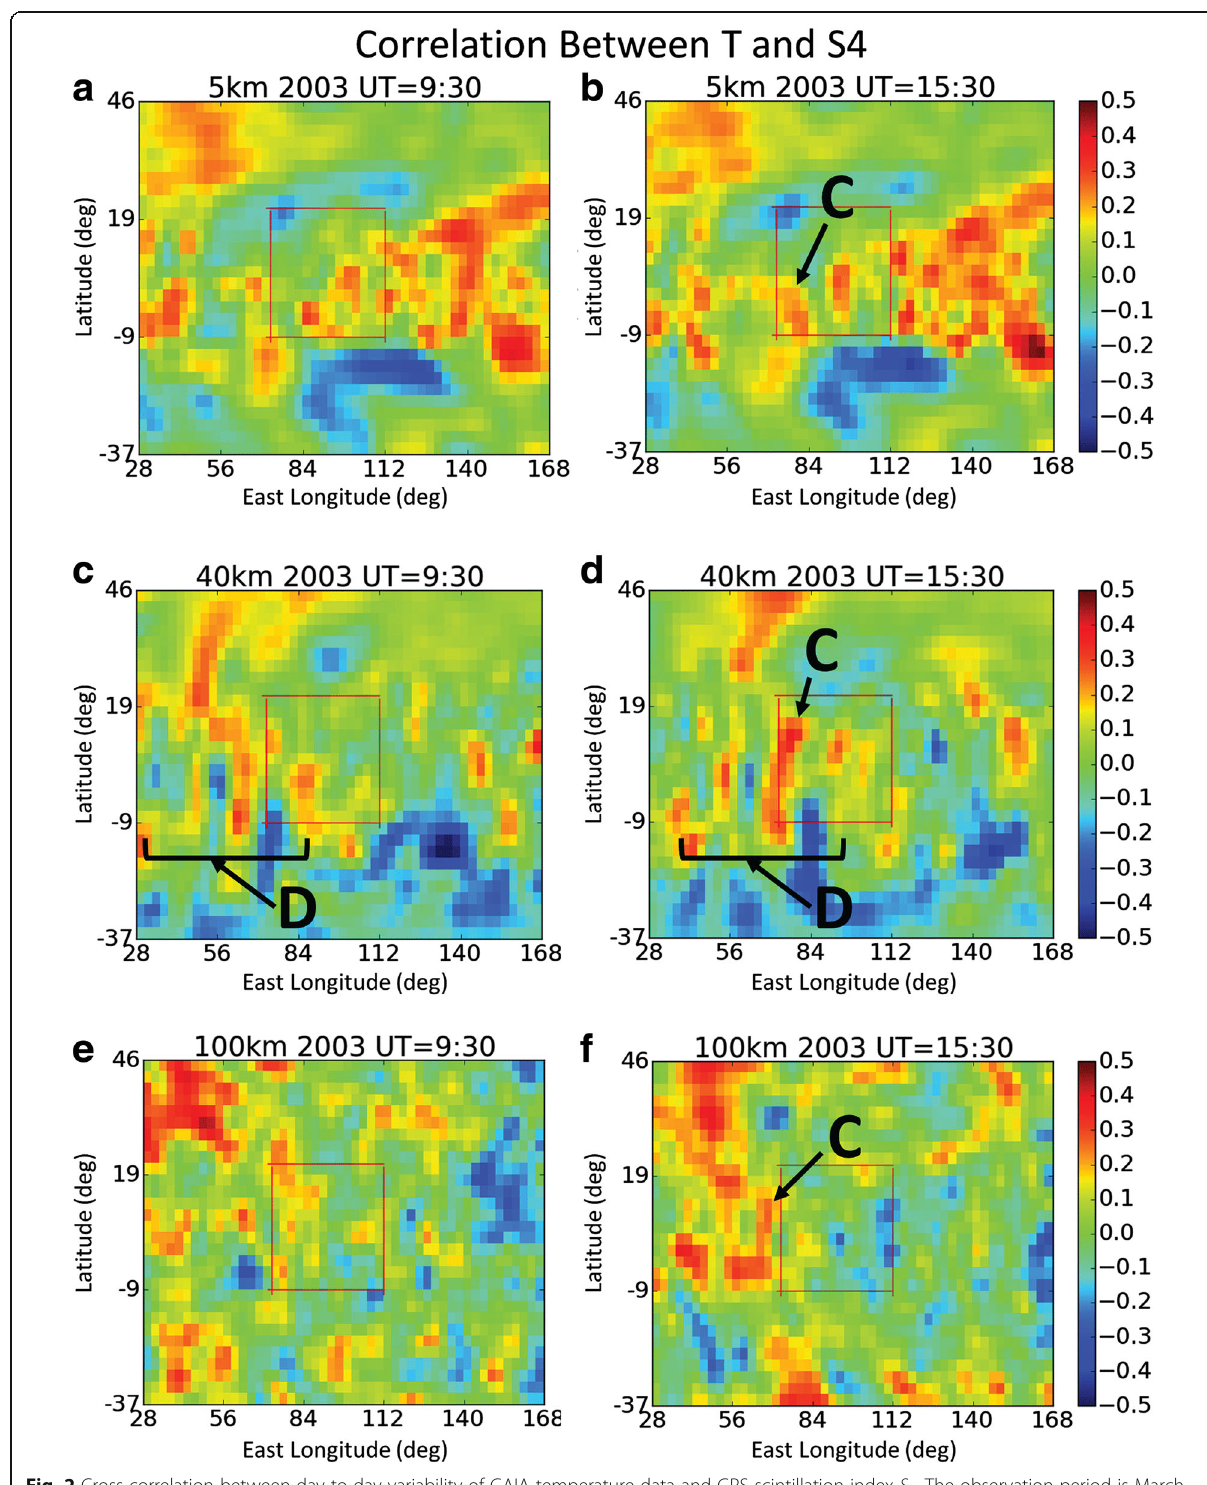
Fig. 2 Cross-correlation between day-to-day variability of GAIA temperature data and GPS-scintillation index S 4 . The observation period is March and April 2003. The red square in each panel indicates the area of data analysis of Fig. 1 (results by Ogawa et al. (2009)). The temperature data are taken at different altitudes and times as follows. a 5 km altitude and 0930 UT (1630LT at Kototabang), b 5 km altitude and 1530 UT (2230 LT at Kototabang), c 40 km altitude and 0930 UT, d 40 km altitude and 1530 UT, e 100 km altitude and 0930 UT, and f 100 km altitude and 1530 UT. “ C ” and “ D ” indicate areas of high correlation